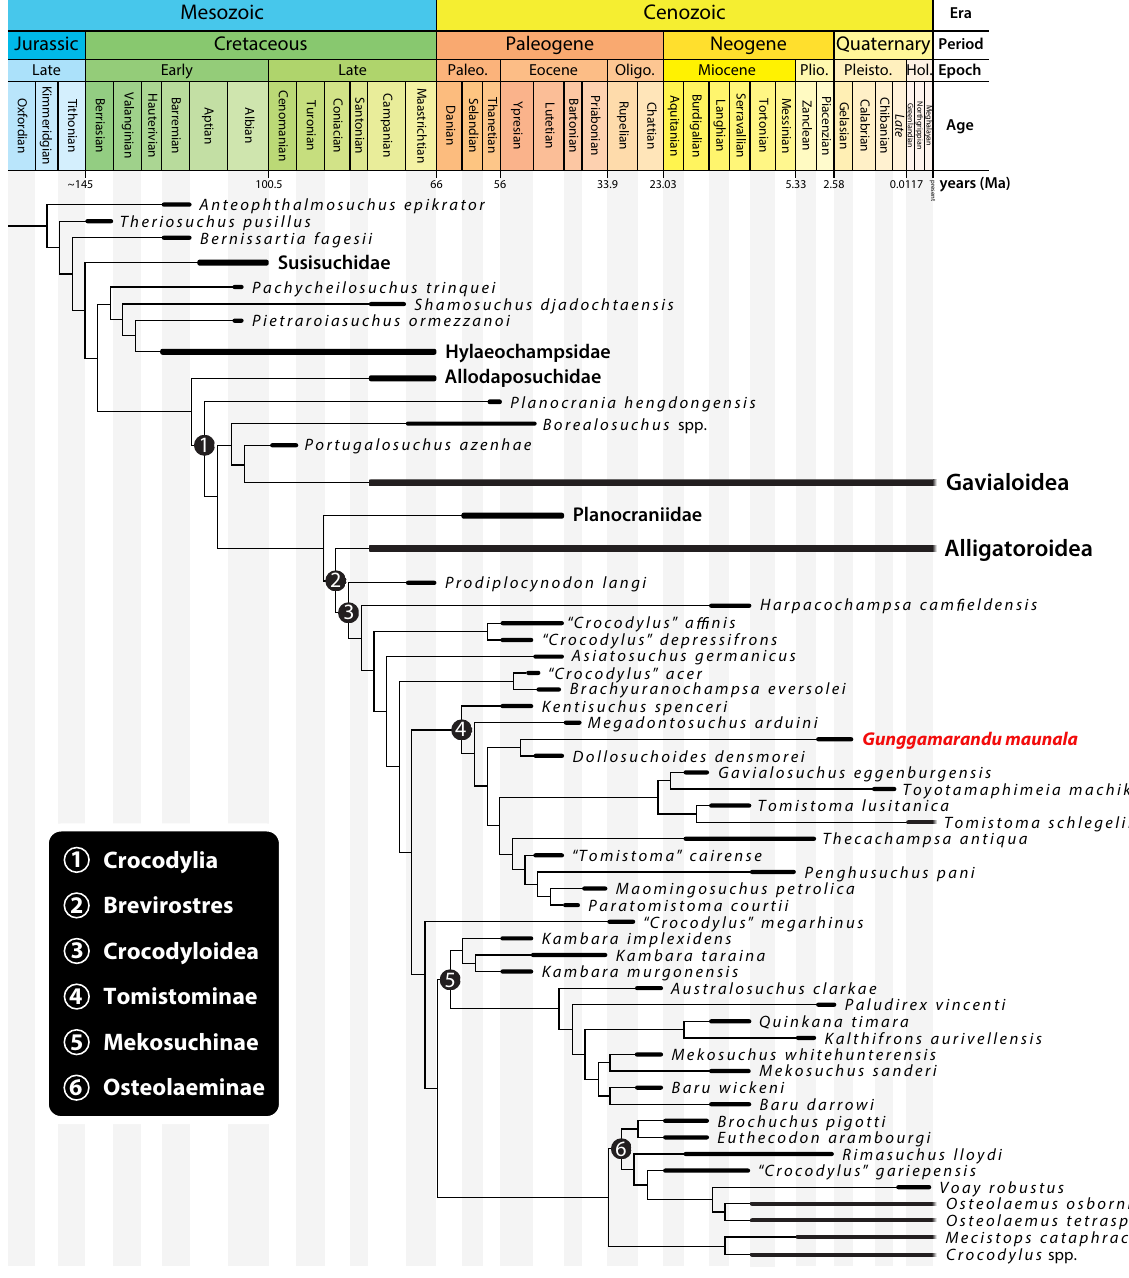
Figure 4. Time-calibrated phylogeny based on the strict consensus results from the analysis that used the Implied Weighting method, with the k (concavity constant) value set to 25.0 (k = 25). The first and last appearance dates for the taxa were acquired from the Paleobiology Database (https:// paleo biodb. org) on 11 October 2020. The geologic dates are based on version 2020/03 of the International Chronostratigraphic Chart (https:// strat igrap hy. org/ chart). For the complete strict consensus topology, nodal values, and more information on the phylogeny see Supplemental Document S2. This figure was created by J. R. in Adobe Illustrator CC 2021 (https:// www. adobe. com/ produ cts/ illus trator.